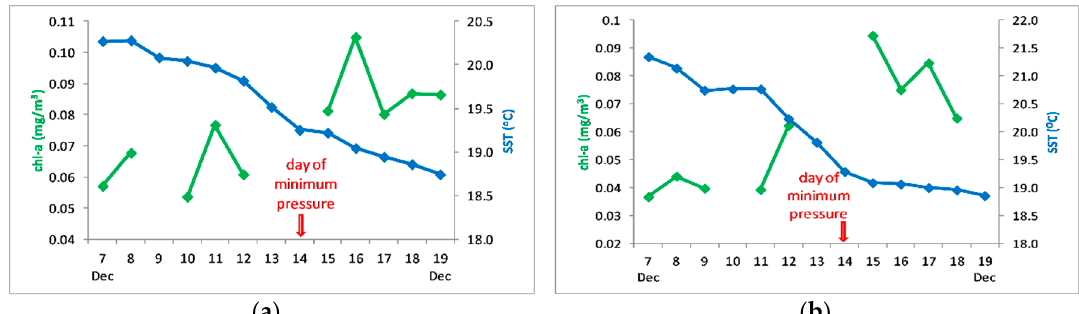
Figure 2. Mean chlorophyll concentration and SST for the time period centered on the event examined ( a ) For the 50 km width area along the cyclone’s track on 14 December 2005; ( b ) For the area of chlorophyll increase marked with P in Figure 1c.